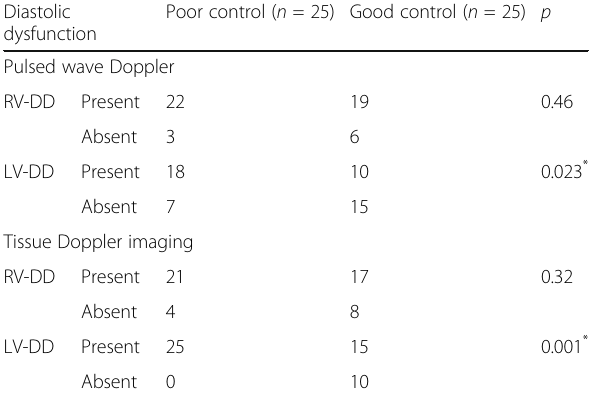
Table 4 Comparison between cases with poor vs. good maternal glycemic control as regards diastolic dysfunction Diastolic